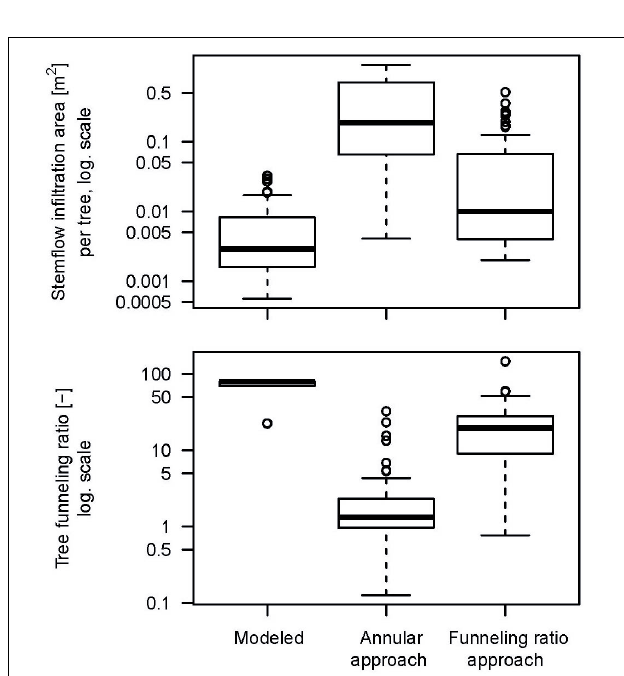
FIGURE 2 | Stemflow infiltration areas and tree funneling ratios for all 65 trees, for the model (Reynolds and Henderson, 1967) and the two funneling approaches (Herwitz, 1986; Tanaka et al.,